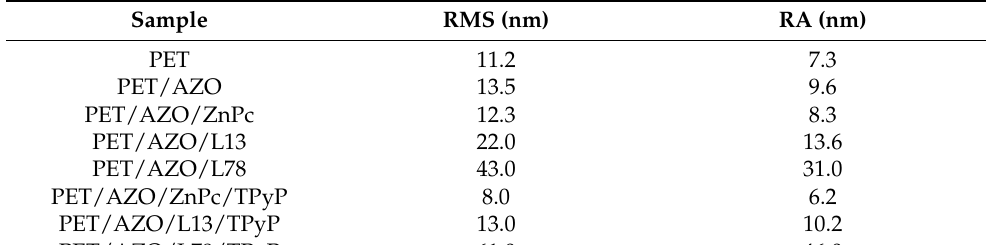
Table 3. Surface amplitude parameters of the single- and bi-layer organic deposited on PET/AZO. For PET and PET/AZO, the RMS and RA are the average values for six samples.